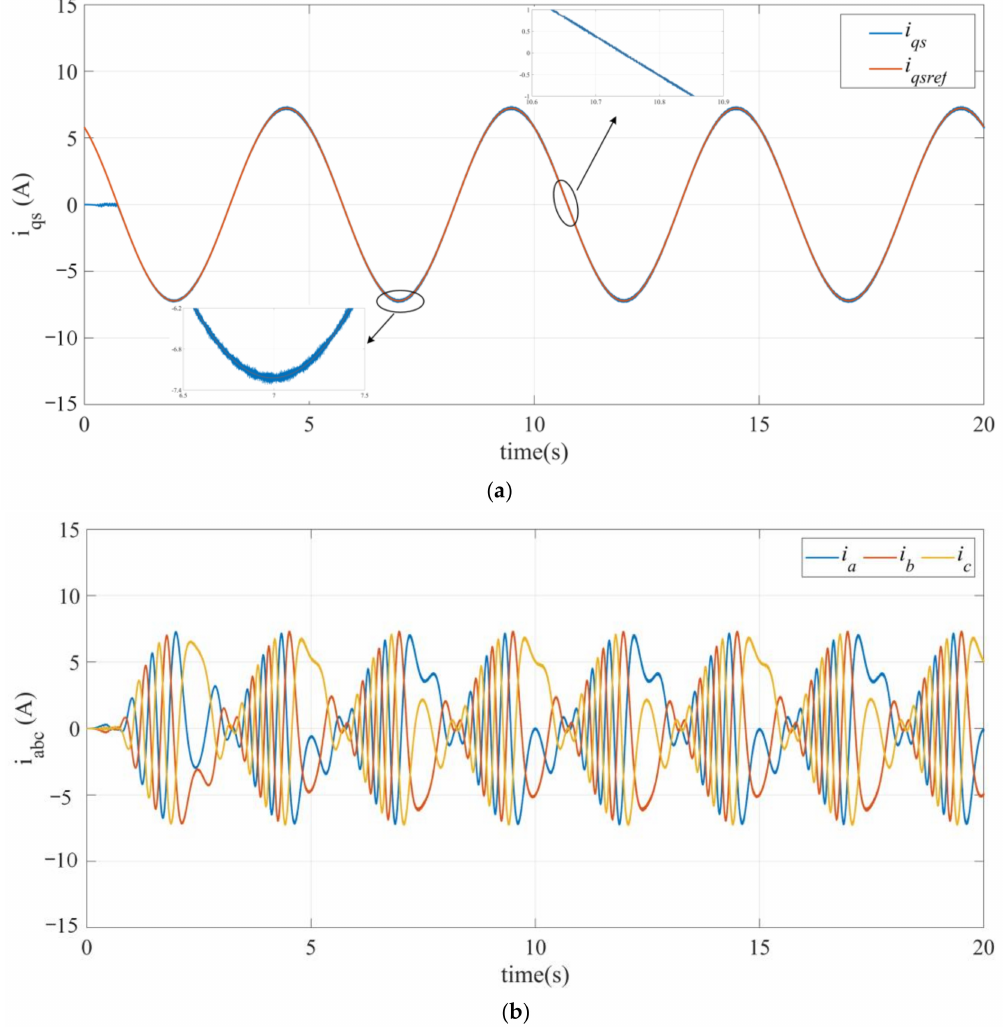
Figure 10. Electrical dynamic response of DDWEC: ( a ) Q-axis current of generator; ( b ) Three phase currents in